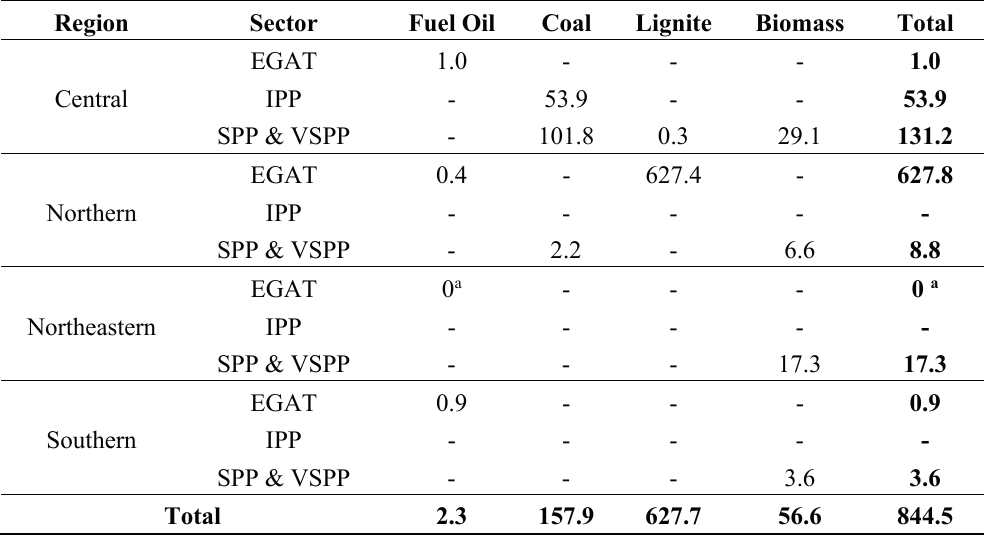
Table 2. Hg Emissions from Thailand’s Power Sector in